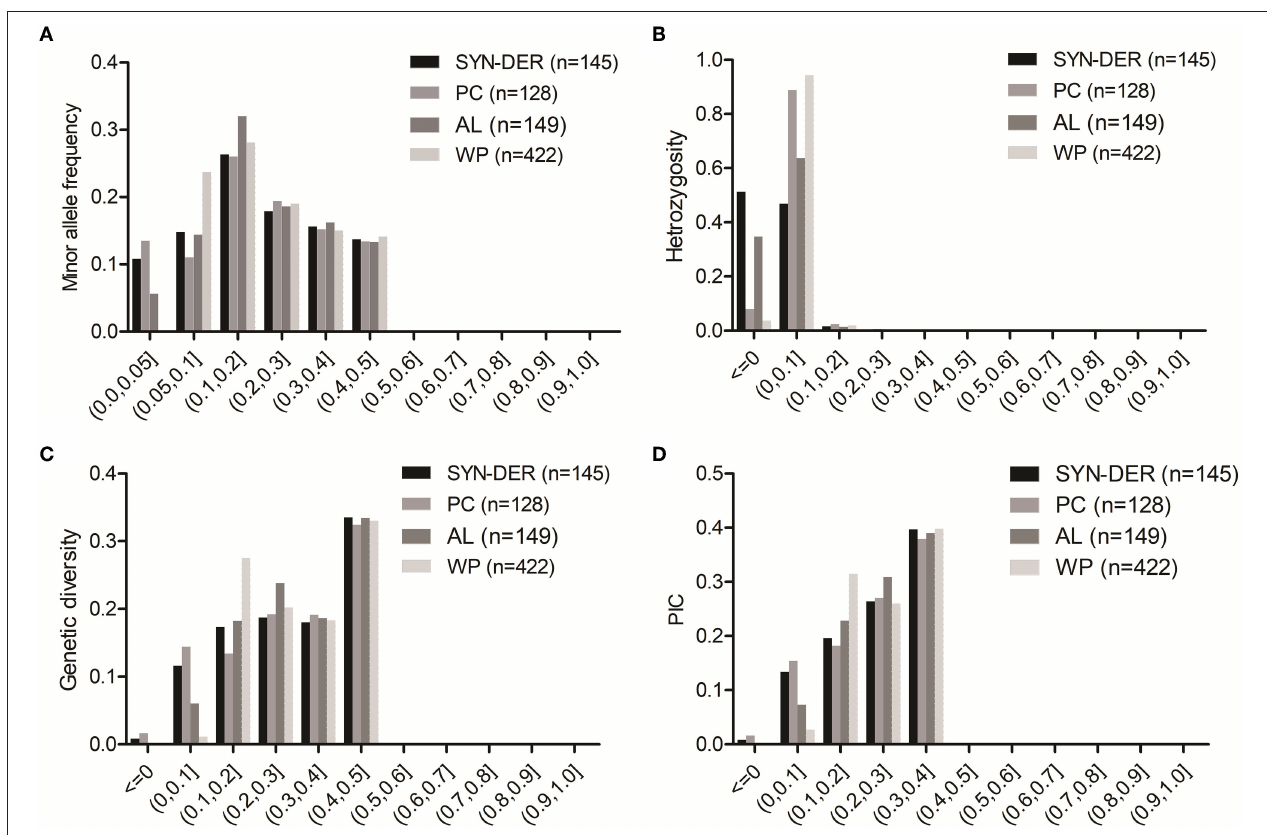
FIGURE 1 | Distribution of minor allele frequency (A) , heterozygosity (B) , genetic diversity (C) , and polymorphic information content (D) across 422 accessions (WP), for 145 synthetic-derived wheats (SYN-DER), 128 Pakistan cultivars (PC), and 149 advanced lines (AL) based on 18,589 SNPs.